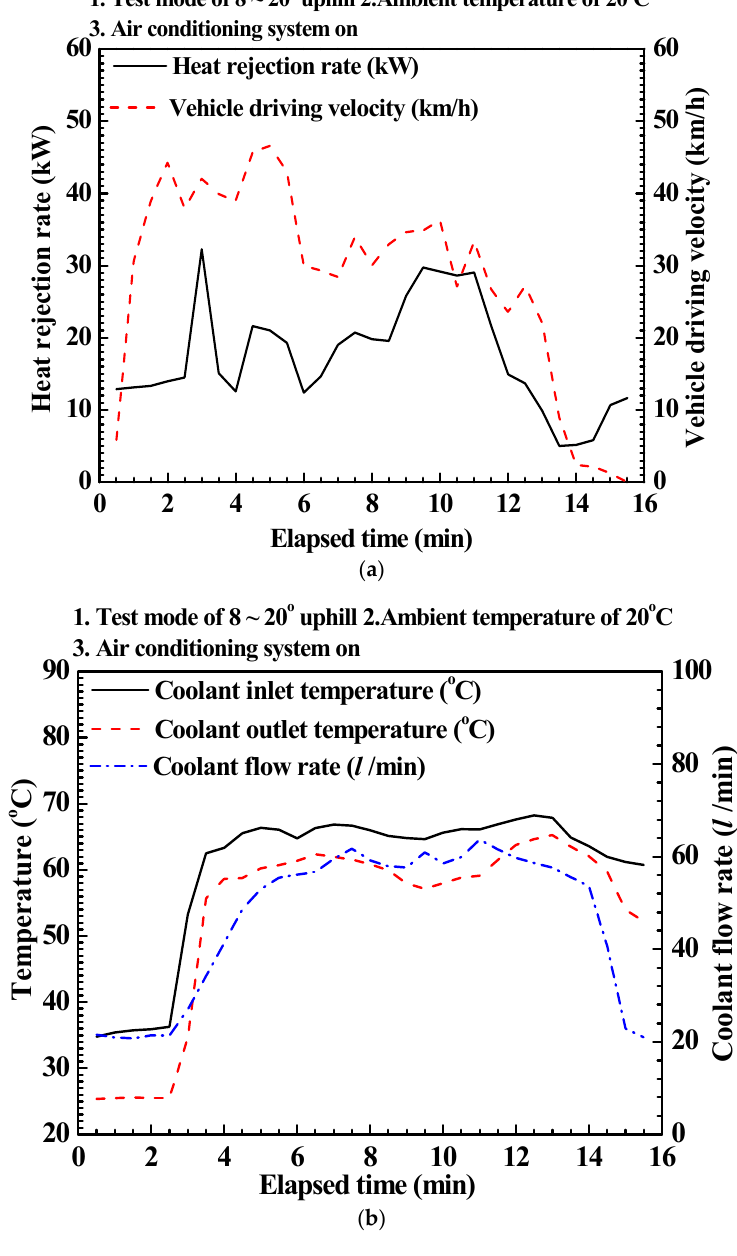
Figure 4. Cooling performance of the stack thermal management system of the fuel ‐ cell electric vehicle, under uphill road conditions. ( a ) Heat ‐ rejection rate; ( b ) Temperature and coolant flow rate.